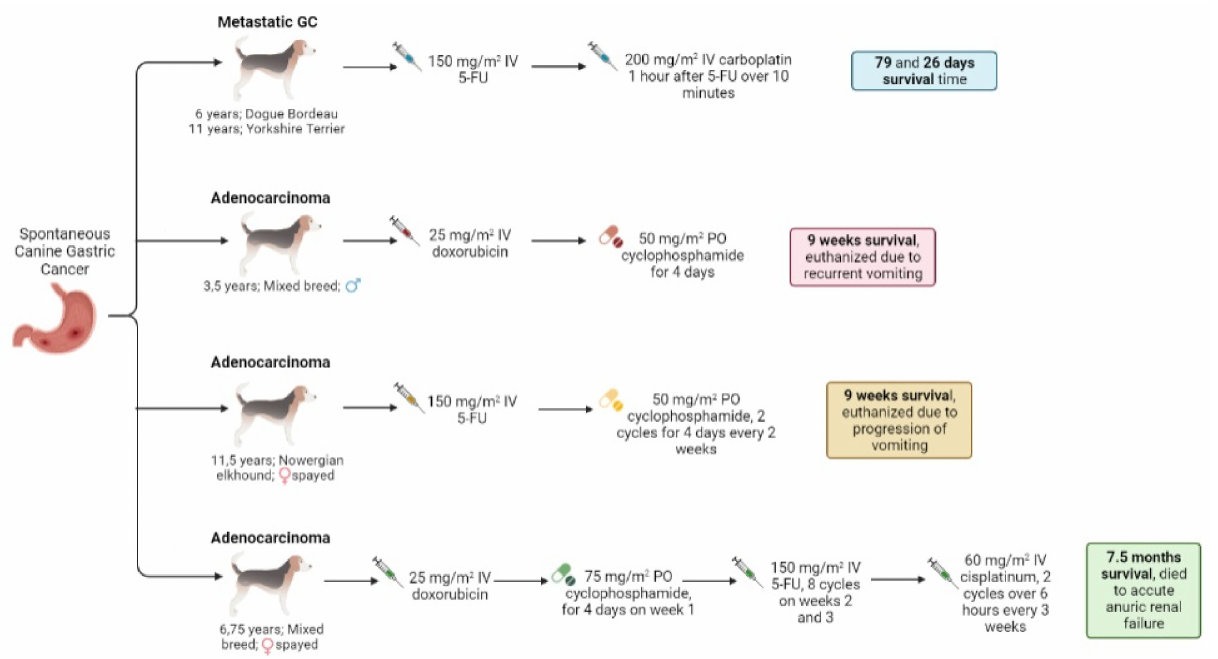
Figure 3. Schematic representation of the most common therapeutical schemes used for canine gastric cancer treatment, based on the available literature